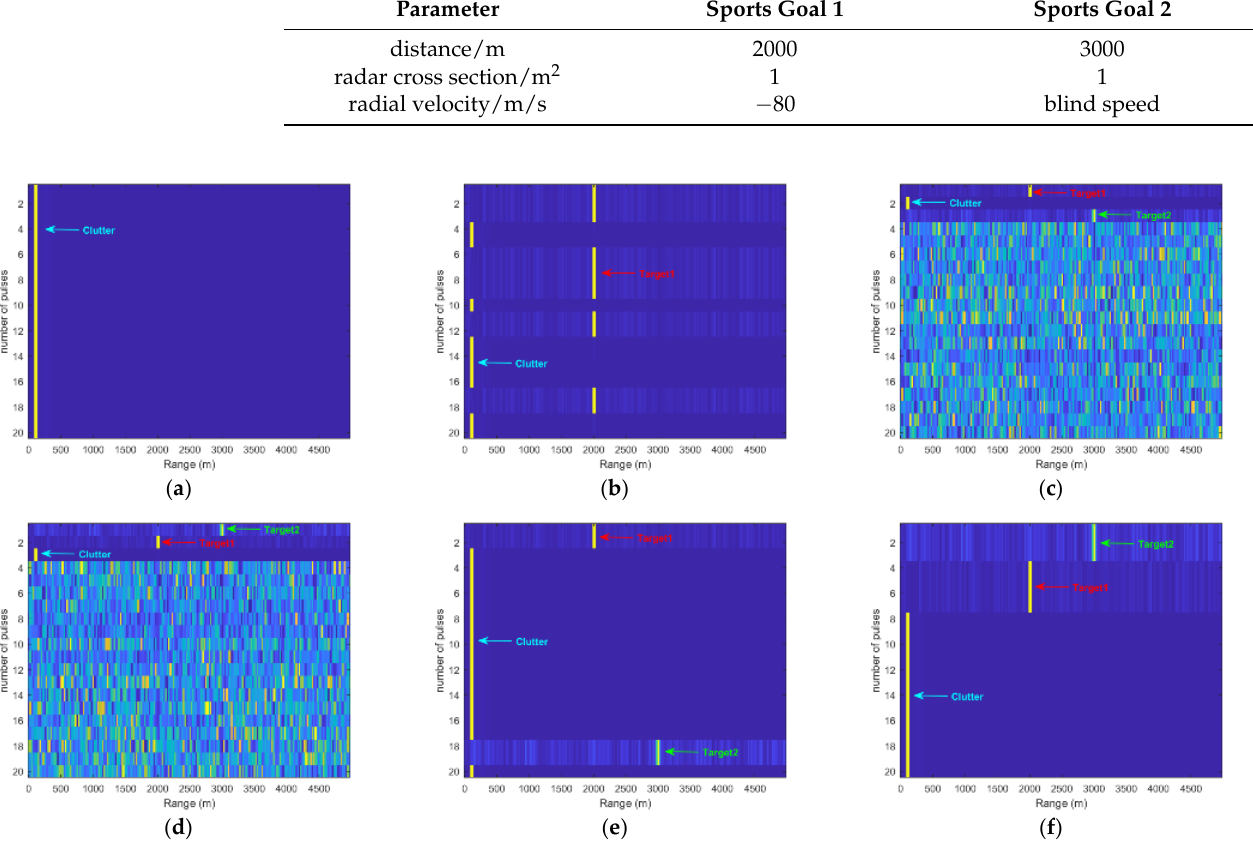
Figure 9. The BSS results for FastICA, PSA, MPSA, NPSA, and PPSA. ( a ) Echo data, ( b ) the result of FastICA, ( c ) the result of PSA, ( d ) the result of MPSA, ( e ) the result of NPSA, ( f ) the result of PPSA.